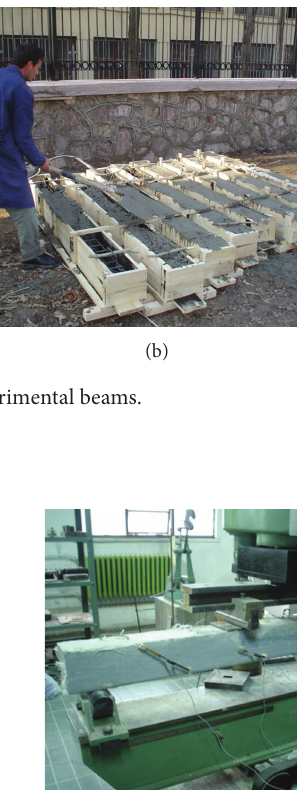
Figure 4: Strain gauge device and